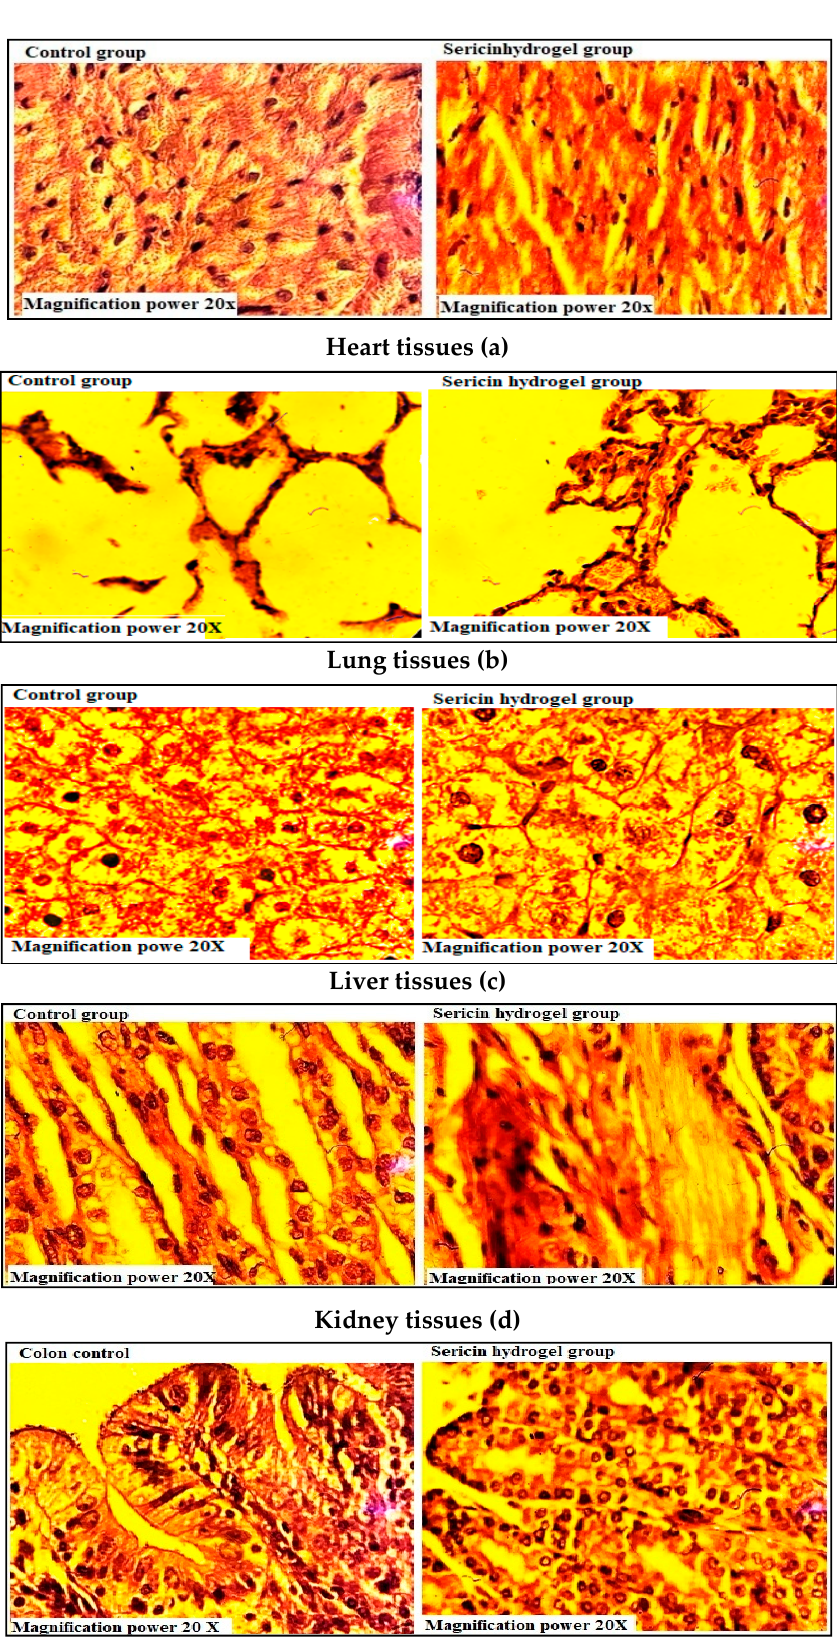
Figure 11. Histological examination of rabbit tissues of control and treatment groups (20× magnification power); ( a ) Heart tissues; ( b ) Lung tissues; ( c ) Liver tissues; ( d ) Kidney tissues.